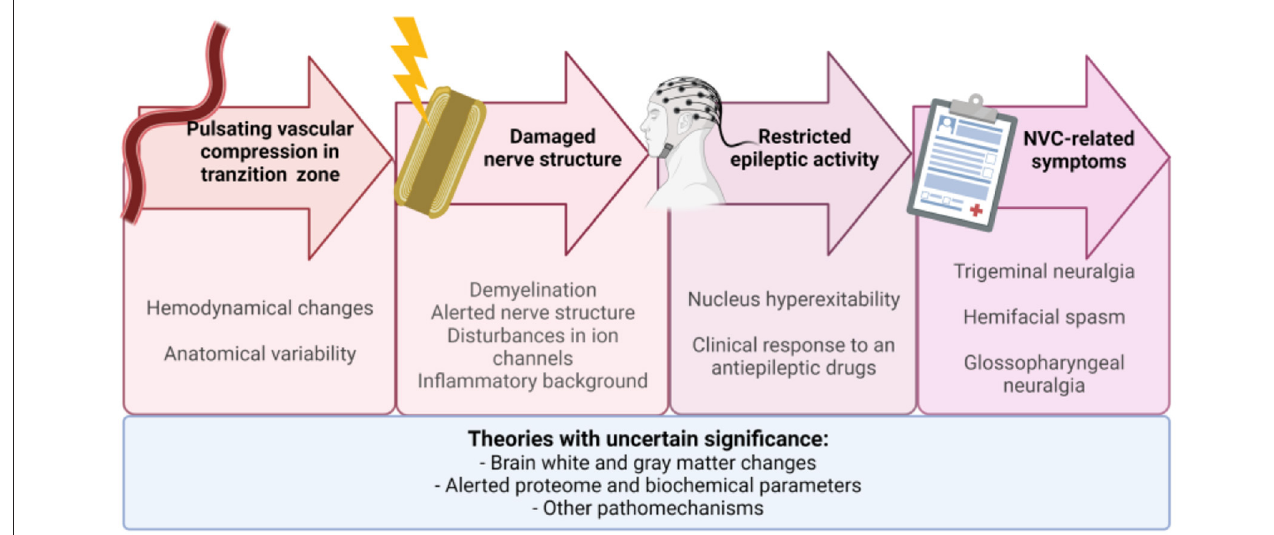
FIGURE 3 | The proposed chain of events leading to neurovascular compression-related symptoms: vascular compression in transition zone → demyelination → nucleus hyperexcitability → symptoms. Not all factors mentioned in Figure 2 are presented here. Future research is needed to understand their role. NVC, neurovascular